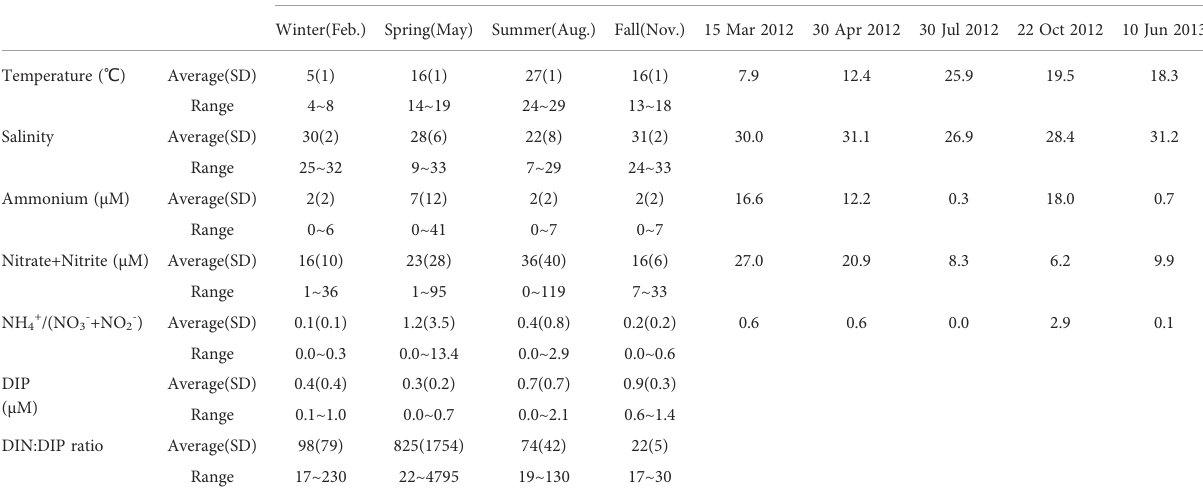
TABLE 1. Seasonal variations in temperature, salinity, ammonium concentration, nitrate + nitrite, ammonium/nitrate + nitrite ratios, dissolved inorganic phosphate (DIP), and DIN:DIP ratio during 2000 – 2013 obtained from Marine Environment Information System (St. 3) and the sampling periods in the YRE (St.